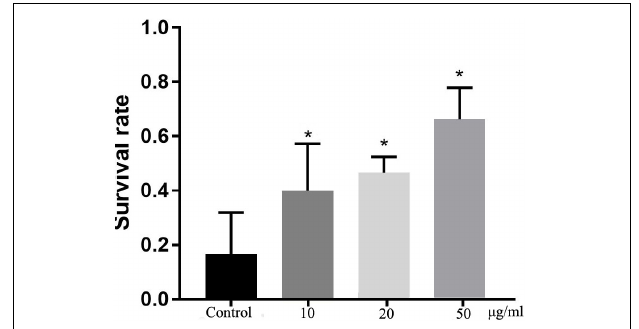
FIGURE 5 | Effect of TFH on A β -induced paralysis in transgenic C. elegans CL4176. Three replicates were examined per treatment. Differences compared to control group were considered significant at *p ≤ 0.05, ** p ≤ 0.01, and *** p ≤